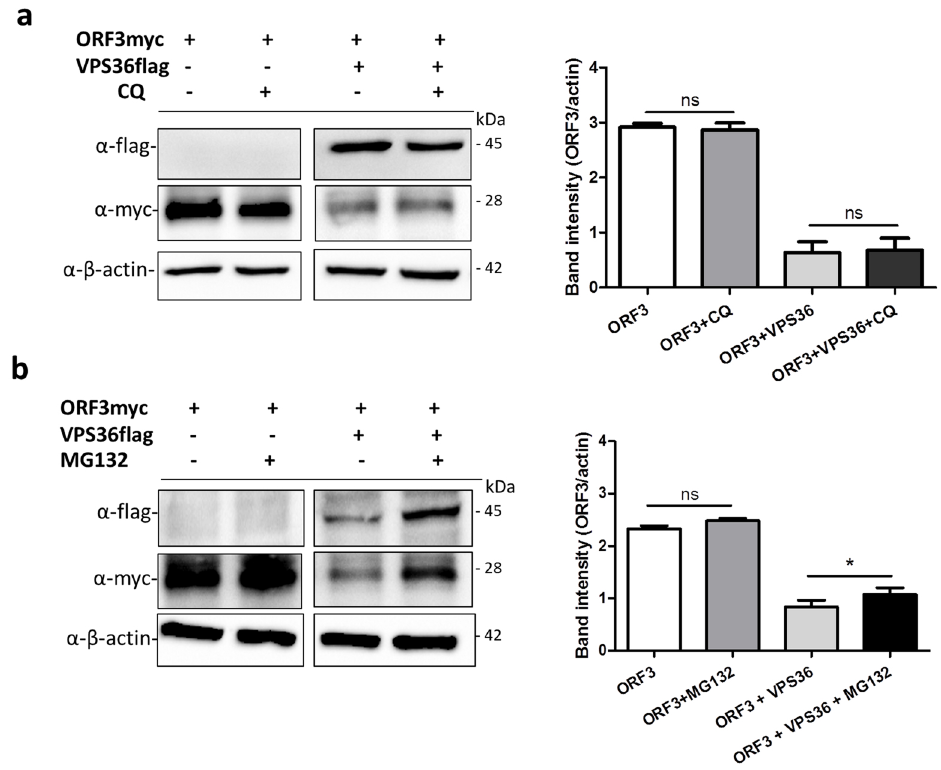
Figure 7. ORF3 expression in the presence of chloroquine and MG132. VeroE6-APN cells were transfected with the plasmids expressing ORF3 and VPS36 proteins. At 8 hpt, cell lysates were treated with chloroquine and MG132 at a concentration of 20 µ M and 10 µ M, respectively, for 1 h. At 48 hpt, cells were harvested and subjected to western blot analysis. Rabbit anti-flag and -myc antibodies were used to probe VPS36flag and ORF3myc proteins. *, p <